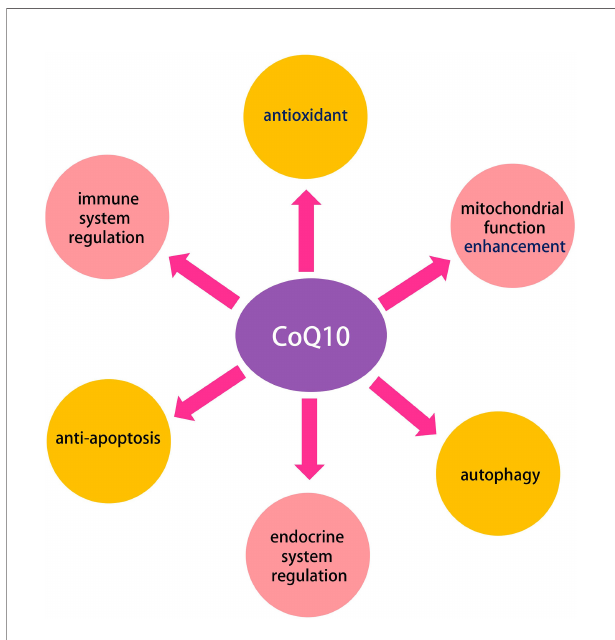
FIGURE 10 | The multiple roles of CoQ10 in